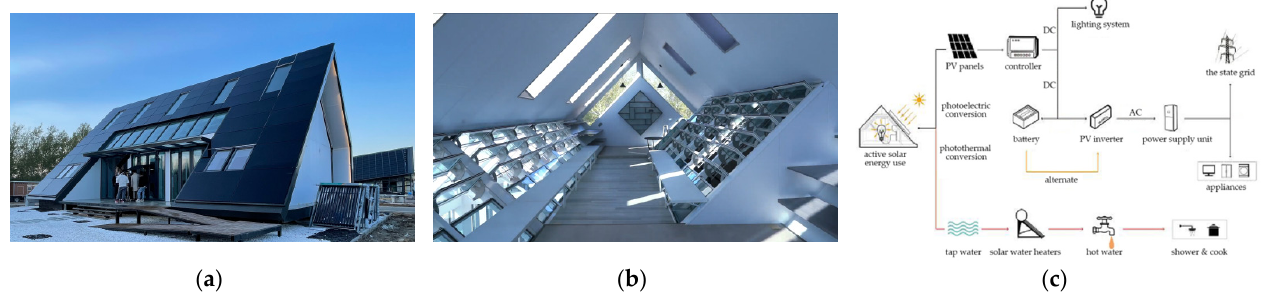
Figure 13. Main results of the Pitched House. ( a ) PV panels on the roof. ( b ) Automatic windows. ( c ) Energy systems.